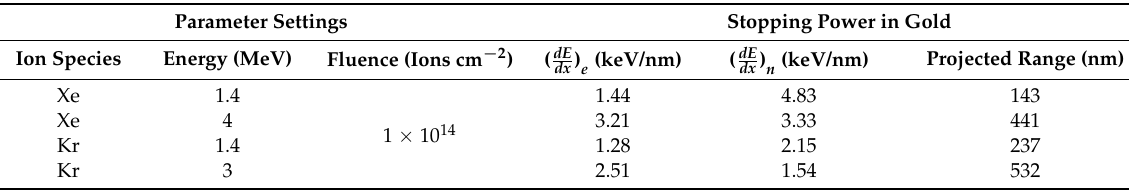
Table 1. Parameter settings in irradiation